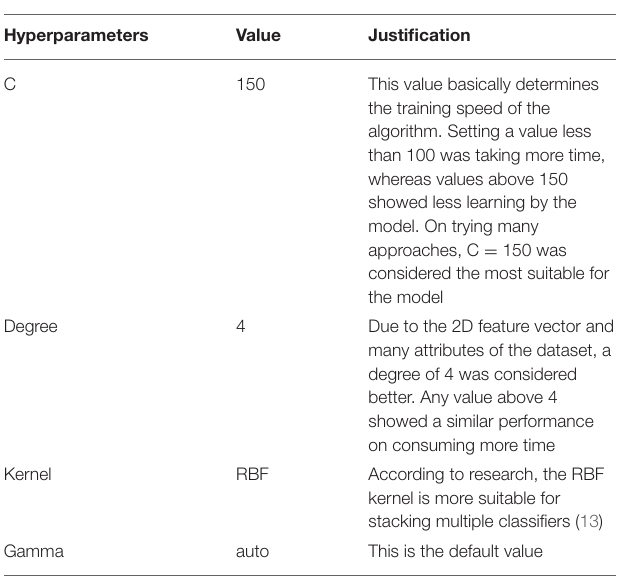
TABLE 9 | Hyperparameters selection for Nu